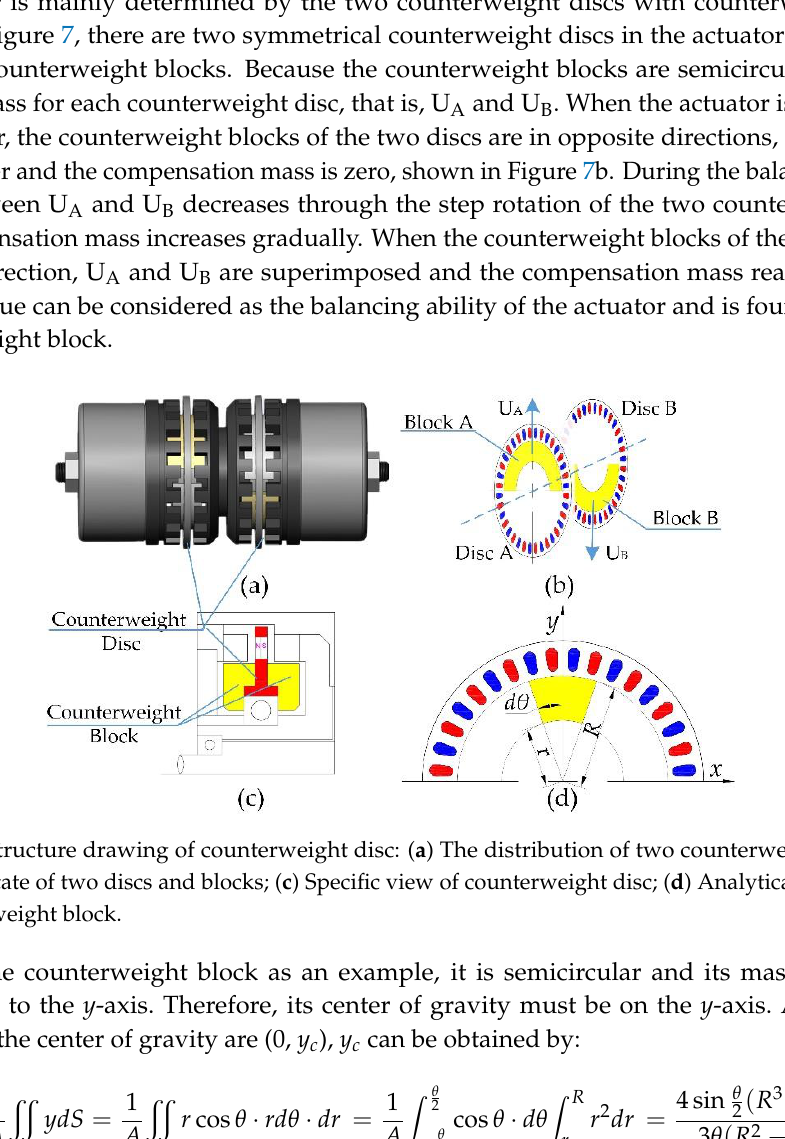
Figure 6. Working principle of existing electromagnetic-ring balancing actuator: ( a ) Physical map of the balancing actuator; ( b ) Spindle with balancing actuator; ( c ) Sectional view of balancing actuator; ( d ) Components of balancing system.